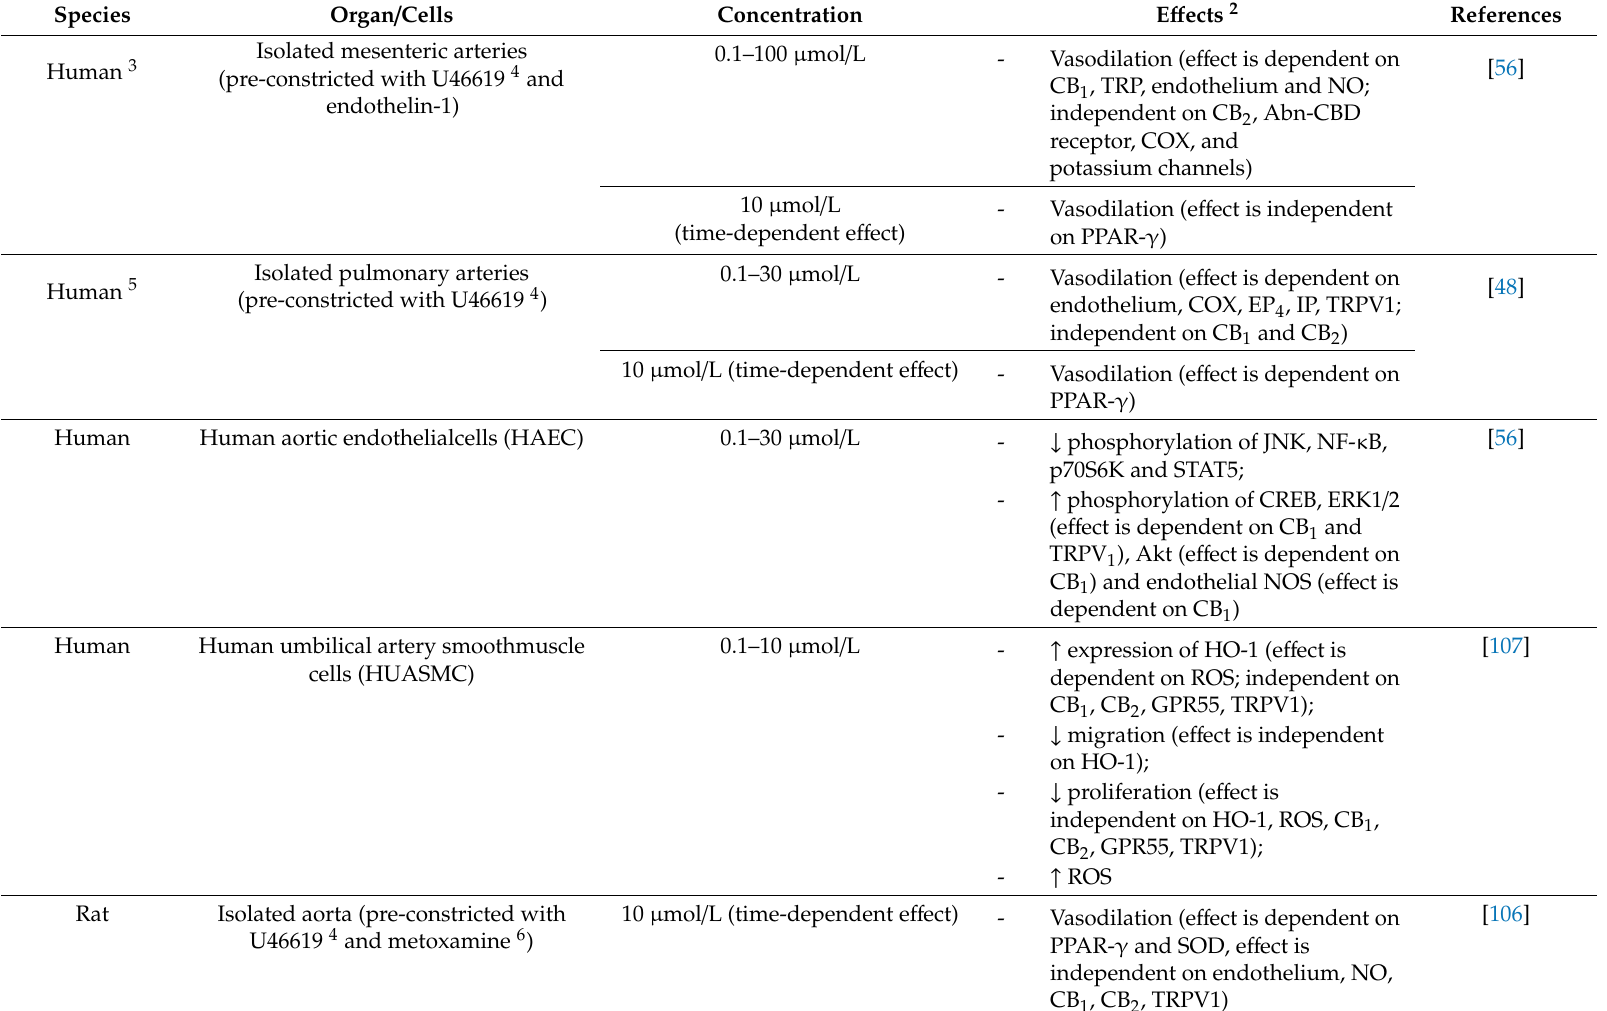
Table 3. In vitro and ex vivo e ff ects of cannabidiol (CBD) in cardiovascular system under physiological 1